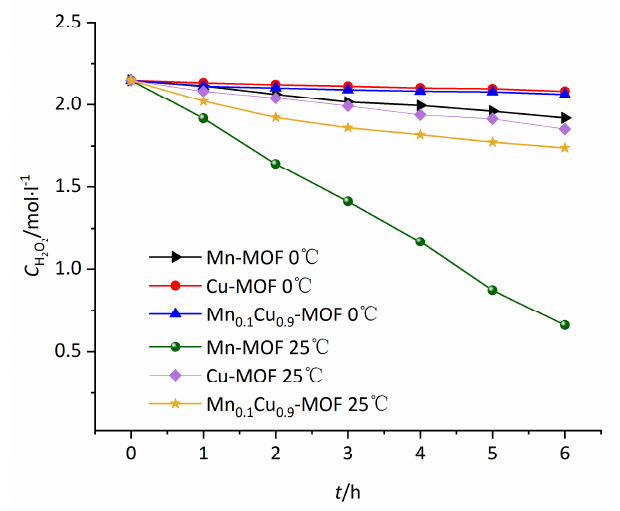
Figure 9. Decompositions of H 2 O 2 catalyzed by Mn-MOF, Cu-MOF, and Mn 0.1 Cu 0.9 -MOF with time at different temperatures.